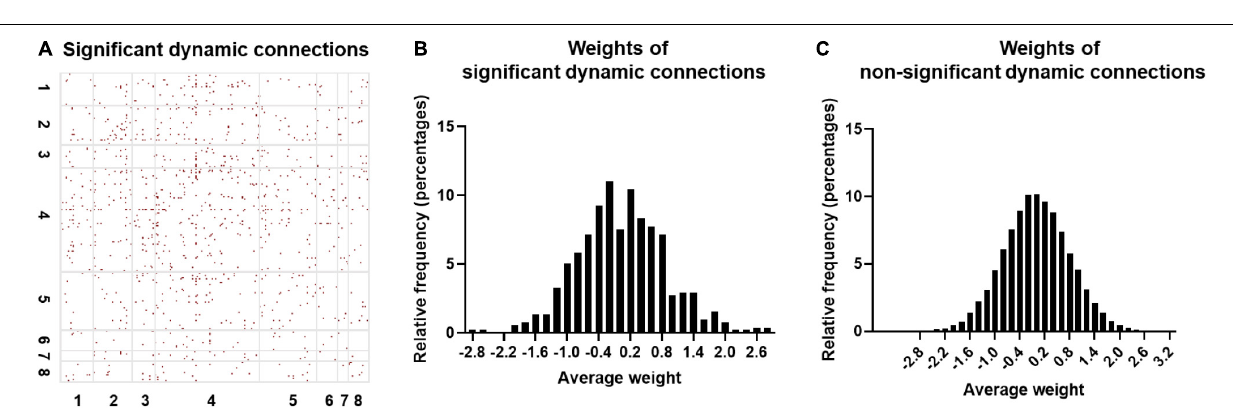
FIGURE 5 | Statistically significant dynamic connections for one randomly selected subject. (A) Distribution of significant dynamic connections (red points) in eight networks. (B) Distribution histogram of deconvolutional weights for significant dynamic connections. (C) Distribution histogram of deconvolutional weights for non- significant dynamic